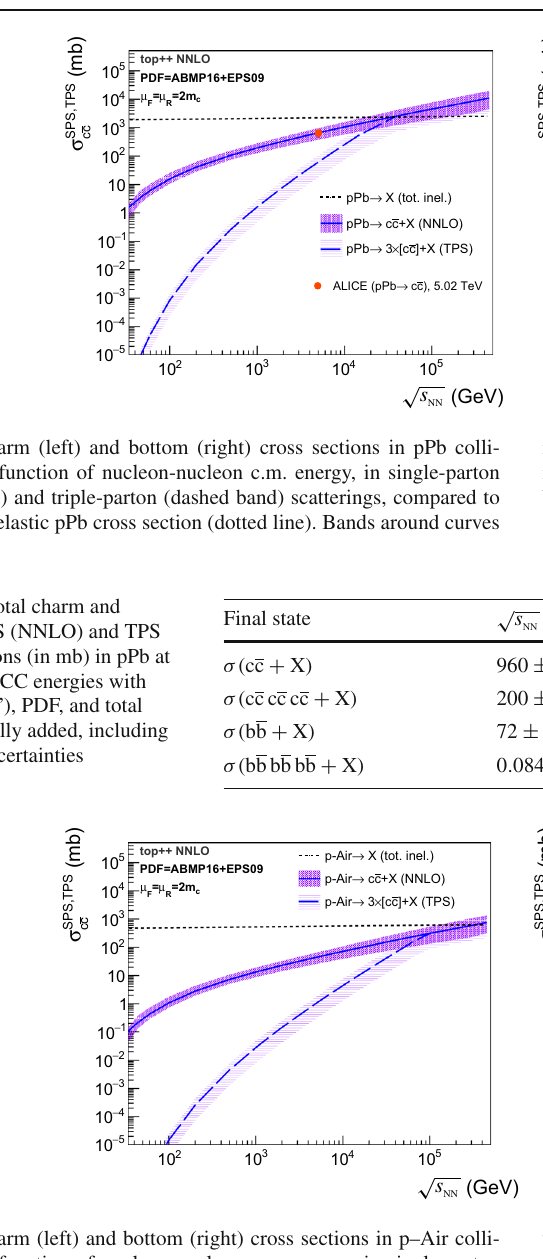
100TeVforSPS(solidbands),TPS(dashedbands)forcharm (left) and bottom (right) production, and total inelastic (dot- ted curve, in both plots). The TPS cross sections are small at √ s ,asthecubeoftheSPScross lowenergiesbutrisefastwith section evolution. Whenever the theoretical central value of the TPS cross section overcomes the inclusive charm